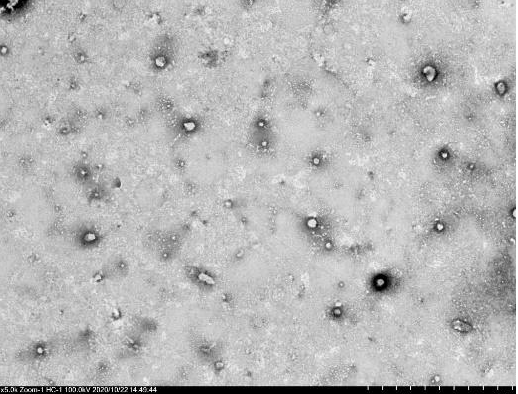
Figure 3. Morphology of the nanofiber of oleanolic acid (OAnf 1:8:20) under transmission electron microscope (TEM).